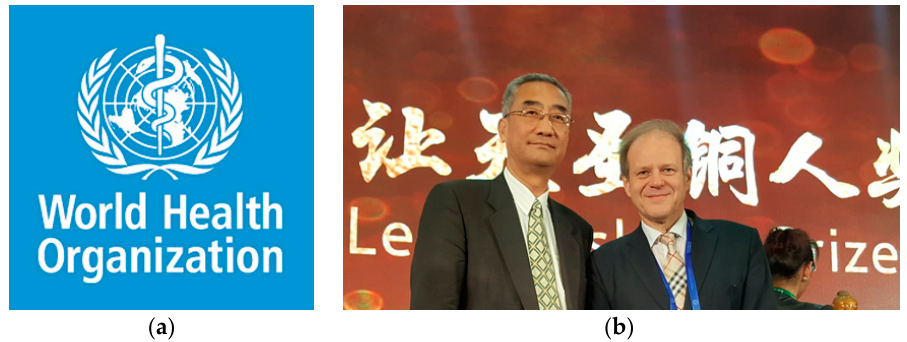
Figure 2. World Health Organization (WHO), Geneva, Switzerland, 2017 ( a ) Dr. Zhang Qi, WHO Coordinator for Traditional, Complementary, and Integrative Medicine (left) with Professor Gerhard Litscher ( b ).